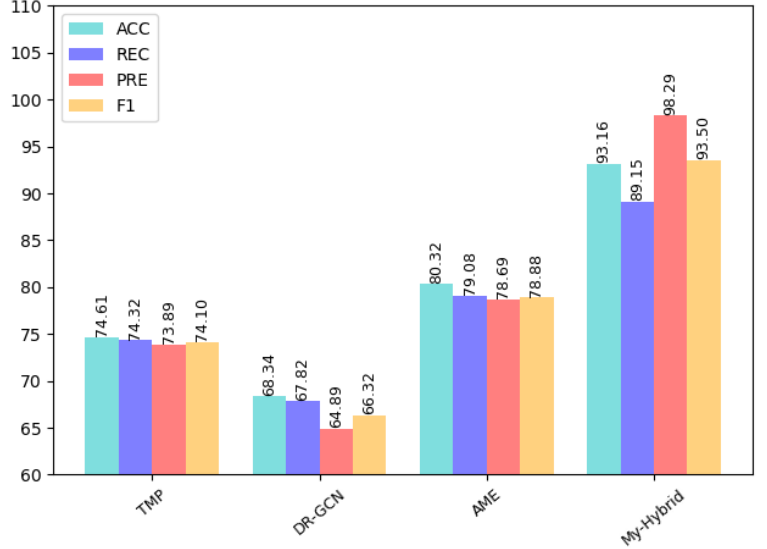
Figure 14. Infinite loop vulnerability detection results.